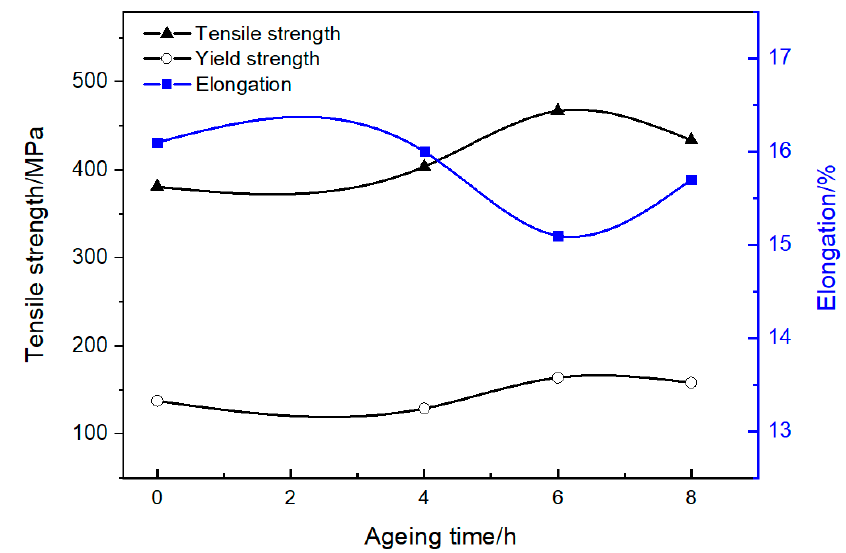
Figure 10. Mechanical properties of squeeze-cast ZL205A under different ageing times.